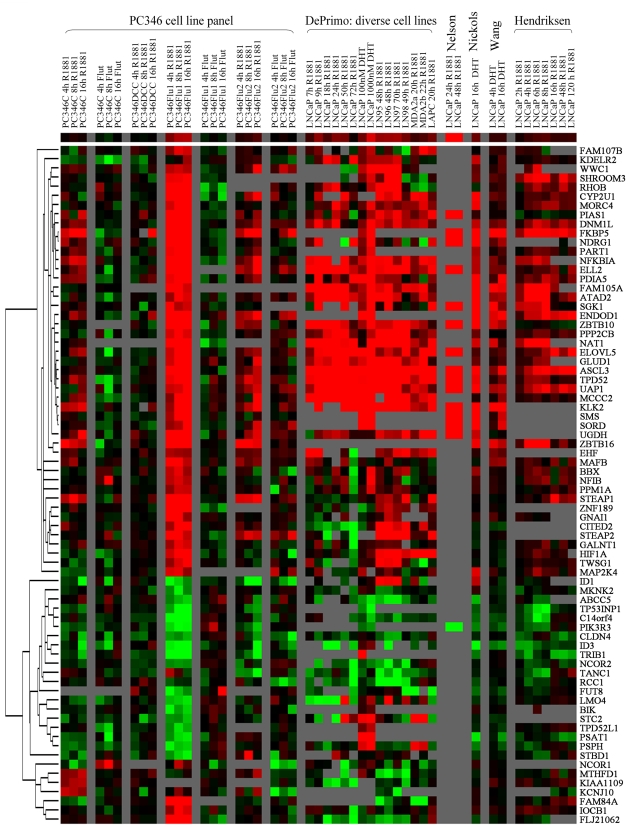
Expression profile of androgen-responsive genes in PC346 cells linked to publicly available databases on AR transcriptional regulation.On the left side, PC346C, PC346Flu1 and PC34Flu2 were exposed to 1 nM R1881 or 1 µM OH-flutamide for 4, 8 and 16h, whereas PC346DCC was stimulated with 1 nM R1881 only. On the right side, our gene signature was assessed in the databases from DePrimo et al., Nelson et al., Nickols et al., Wang et al. and Hendriksen et al. (see Table 7 for database details). Heat-map is presented for the 2log expression ratio between hormone-treated samples and respective time-matched vehicle controls. Red and green colors represent induction and repression, respectively, whereas black indicates no regulation. Grey squares indicate missing data due to low expression, poor data quality or absence of probes for the respective transcript in the array platform used for the study.